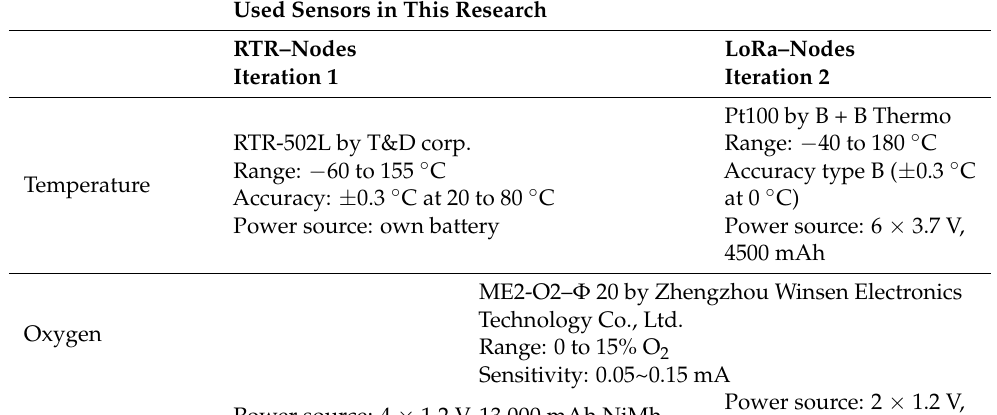
Table 1. Overview of used sensors and their power source in the present nodes. The correct voltages needed were provided by DC-DC